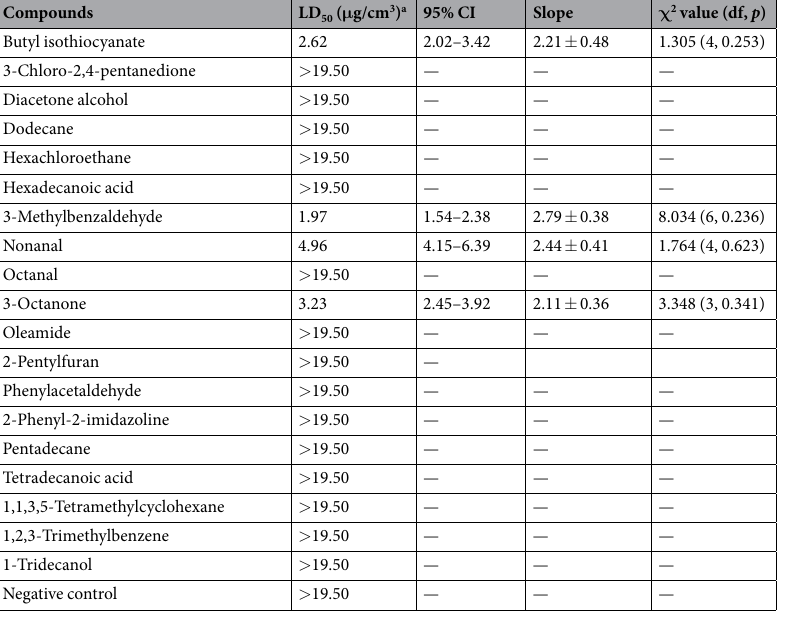
— — Table 3. Acaricidal toxicity of hydroxybenzaldehyde analogues, methylbenzaldehyde analogues and synthetic acaricide against T . putrescentiae , using a vapor bioassay ( a LD 50 is the average of 5 determinations, with 30 adult mites per replication; Exposed for 24 h).